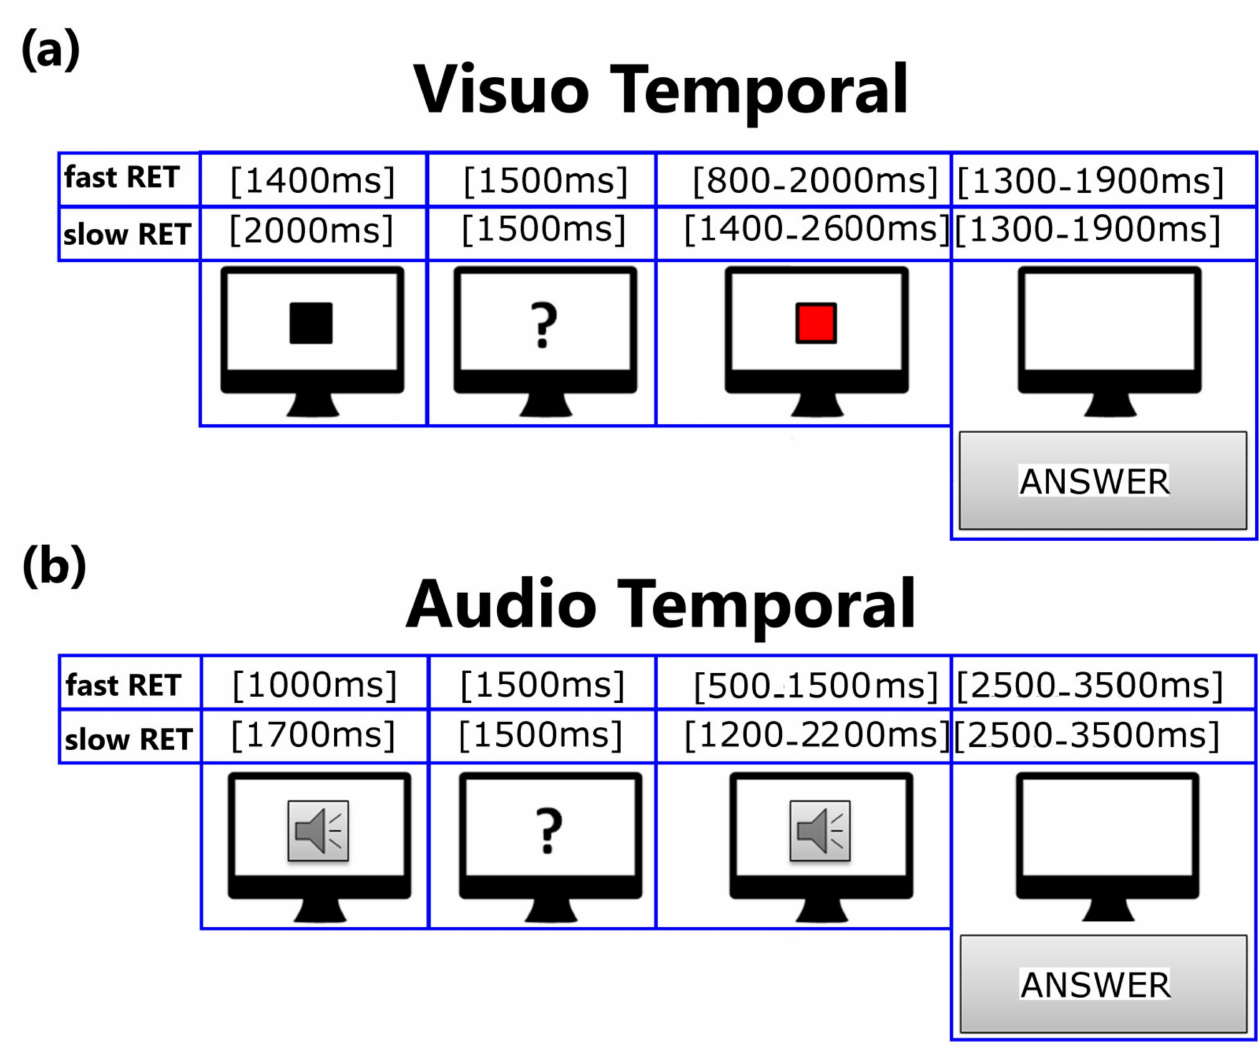
Figure 1. Example of a trial of VTT and ATT. ( a ) In VTT, the reference was a black square (size 190 × 190 pixels) appearing at the center of the screen for either 1400 ms (fast RET) or 2000 ms (slow RET). 1500 ms later (ISI), the target (a red square, 190 × 190 pixels) appeared in the same position. For the fast RET condition, TET exposure time was either between 800 ms and 1100 ms (shorter TET ), or 1400 ms (equal TET ), or between 1700 ms and 2000 ms (longer TET ). For the slow RET condition, TET could either be between 1400 ms and 1700 ms (shorter TET ), or 2000 ms (equal TET ), or between 2300 ms and 2600 ms (longer TET ). ( b ) In ATT, reference was a beep tone (WAV, 440 Hz, 46 dBA, duration 2000 ms, 16 BIT), which was presented either for 1000 ms (fast RET) or 1700 ms (slow RET) by two speakers arranged in line with the computer screen, to the right and left side of it. 1500 ms later (ISI), the target was presented. For the fast RET condition, TET could either be between 500 ms and 750 ms (shorter TET ), or 1000 ms (equal TET ), or between 1250 ms and 1500 ms (longer TET ). For the slow RET condition, TET could either be between 1200 ms and 1450 ms (shorter TET ), or 1700 ms (equal TET ), or between 1950 ms and 2200 ms (longer TET ). The time intervals for the response were between 2500 ms and 3500 ms for each